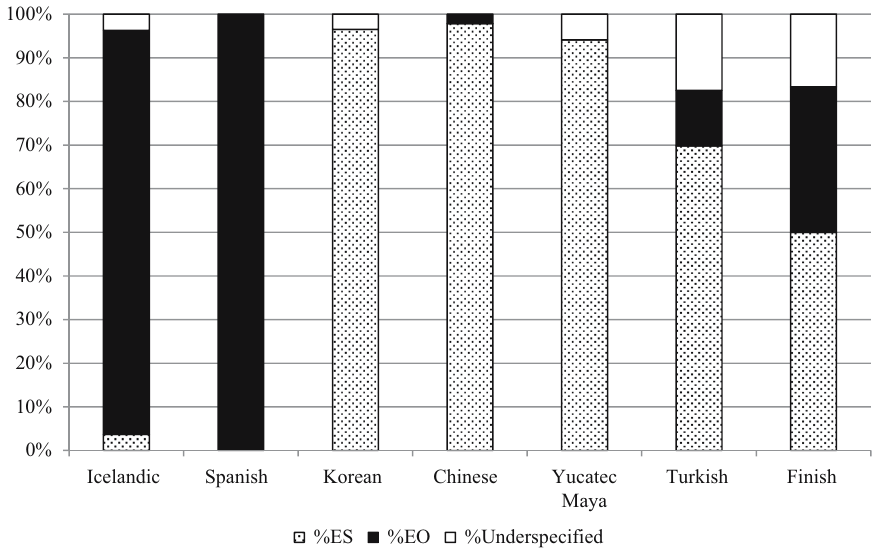
Figure 1: Distribution of basic forms in sample ( n = 435 )